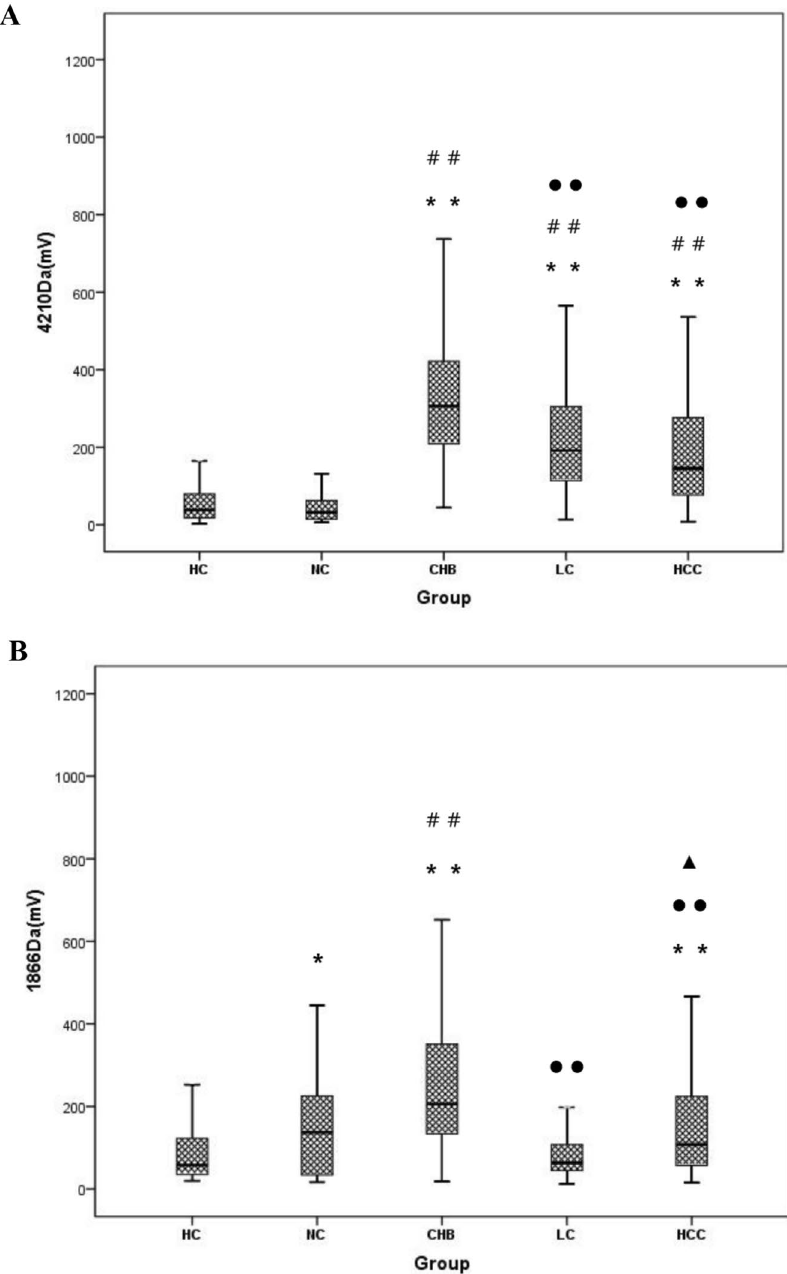
Figure 1. Box plots of the detection results of the 4210 Da and 1866 Da polypeptides in the sera of patients from each group. The top and bottom of the boxes represent the first and third quartiles, respectively, and the horizontal lines across the boxes represent the median values. ( A ) 4210 Da polypeptide ( χ 2 = 267.3, P < 0.001). ( B ) 1866 Da polypeptide ( χ 2 = 127.4, P < 0.001). HC healthy control, NC natural clearance, CHB chronic hepatitis B, LC liver cirrhosis, HCC hepatocellular carcinoma. ** P < 0.01 vs. HC; * P < 0.05 vs. HC; ## P < 0.01 vs. NC; P < 0.01 vs. CHB; ▲ P < 0.05 vs. ●● 4210 Da alone, P = 0.189; Fig. 2A), as calculated with the logistic regression model equation: Logit (Y) = − 4.150 + 0.005 × 1866 Da + 0.022 × 4210 Da ( χ 2 = 235.47, P < 0.001). The diagnostic critical values of 4210 Da and 1866 Da and their combination for CHB from HC via logistic regression were 139.00 mV, 129.50 mV and 0.660, respectively. The sensitivity, specificity, Youden index, accuracy of judgment, positive predictive value, negative predictive value, positive likelihood ratio and negative likelihood ratio of the diagnostic indicators (4210 Da, 1866 Da and their combination via logistic regression) were as follows: 87.7%, 78.5% and 85.4%; 93.8%, 77.7% and 96.2%; 81.5%, 56.2% and 81.5%; 90.8%, 78.1% and 90.8%; 93.4%, 77.9% and